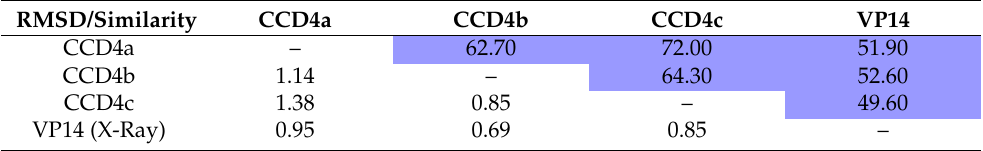
Figure 1. Ribbon representation of the CCD4s models: CCD4a (green), CCD4b (blue), CCD4c (pink), and VP14 (red). α -helices 1 and 3 are indicated by arrows. Table 1. RMSD values (lower diagonal) and percentage of sequence similarity (upper diagonal, colored in violet) calculated for the CCD4a, CCD4b, and CCD4c models as compared to the crystal structure of VP14. The sequence alignment was obtained with the BLOSUM62 substitution matrix (gap open penalty = 7, gap extension penalty = 1) using the MOE-Align program (Molecular Operating Environment [18]).